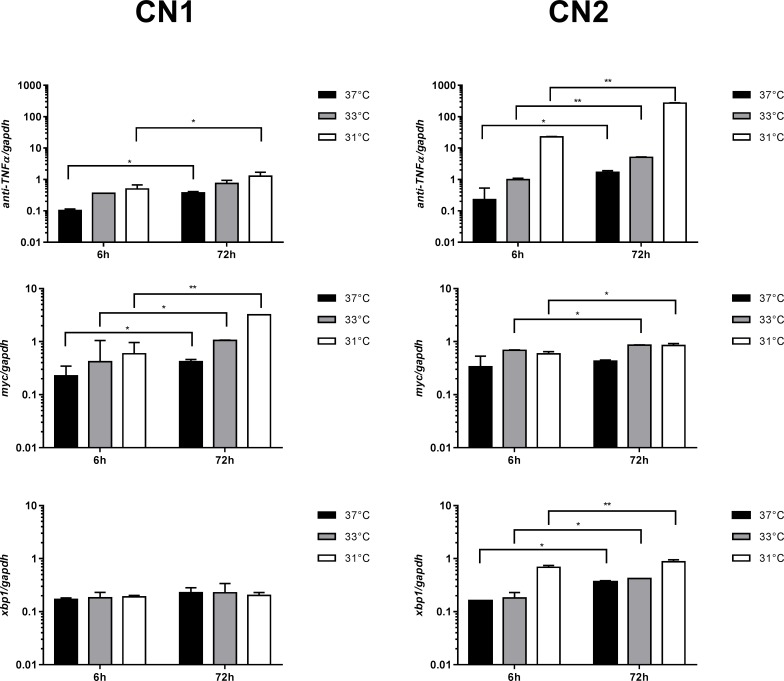
Differential expressions of mRNA encoding for anti-TNFα, Myc and XBP1s in CN1 and CN2 at 37°C (■), 33°C (■) and 31°C (■).The relative expressions of anti-TNFα, myc and xbp1s were analysed at 6 and 72 h of culture using RT-qPCR and gapdh as reference gene. The results are expressed and plotted in log10. Significant differences (α = 0.05) between temperature and clones according to the Tukey HSD test are indicated by the p-values in the S5 Table (Supplementary file). Differences in the expression levels of anti-TNFα, xbp1s and myc between both culture periods (i.e. 6 h vs 72 h of culture) were evaluated by a t-test (S4 Table, Supplementary file) and expressed in the figure as: * p < 0.05, ** p < 0.01 and p < 0.001.